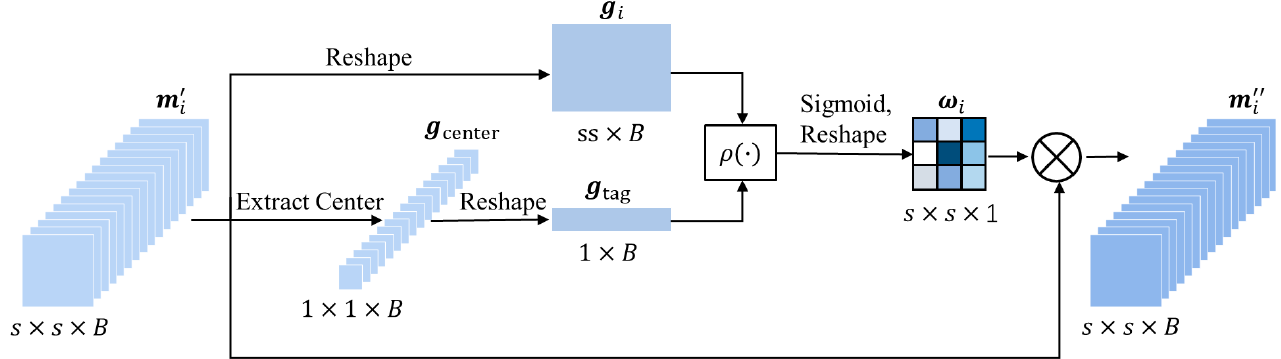
Figure 4. Detailed work fl ow of the SAAM.